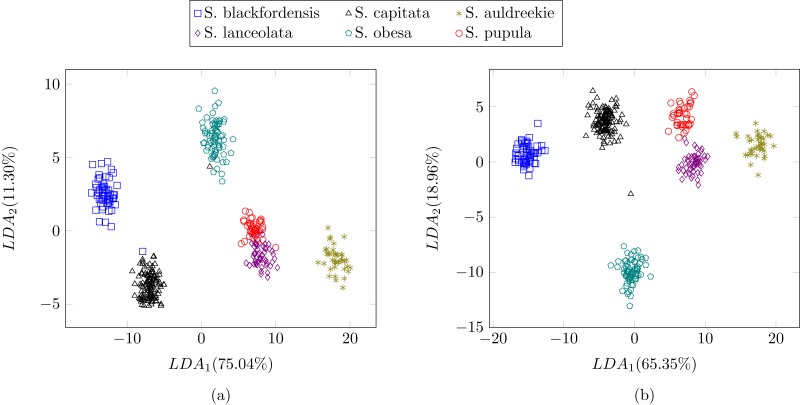
Comparison between (Mann et al., 2004) (A) process and the described method (B).